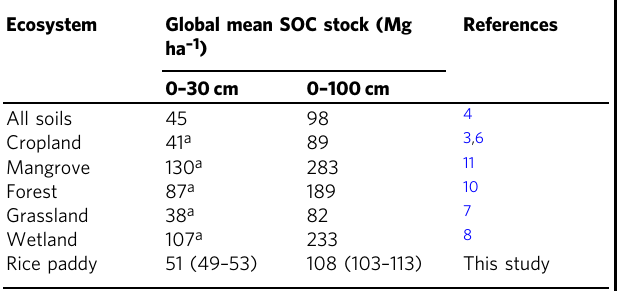
Table 1 Recent estimates of SOC stocks for the world ’ s main terrestrial